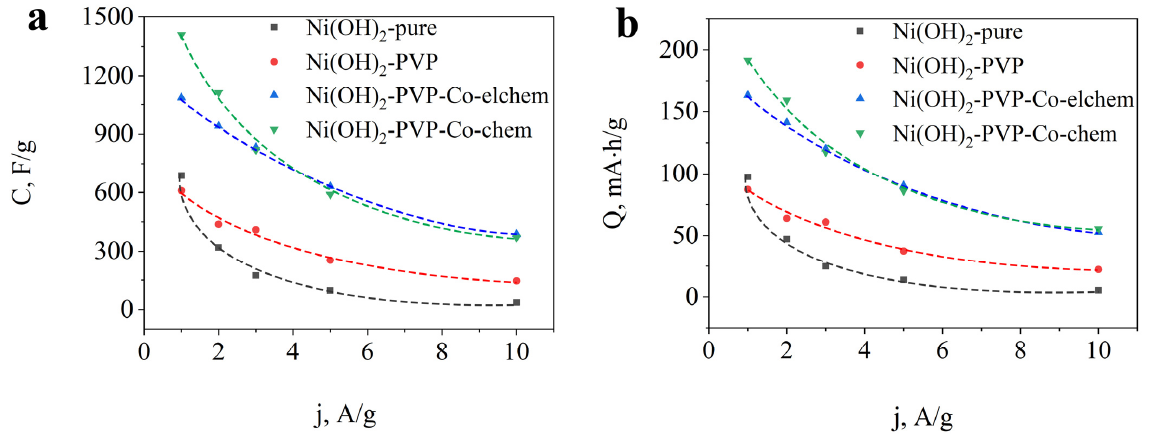
Figure 11. Specific capacitance ( a ) and capacity ( b ) and the specific current density dependencies for electrodes mass loadings were Ni(OH) 2 -pure—18.7 mg; Ni(OH) 2 -PVP—19.8 mg; Ni(OH) 2 -PVP-Co- elchem—17.3 mg; Ni(OH) 2 -PVP-Co-chem—13.3